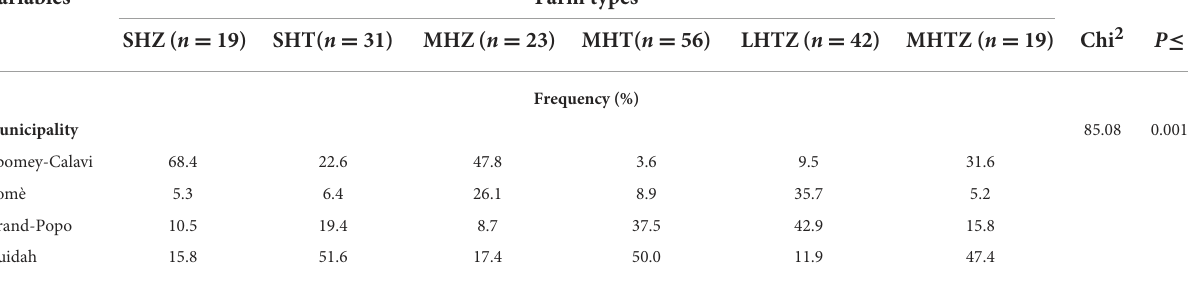
TABLE 6 Geographical distribution of peri-urban dairy farm types across four study locations in South